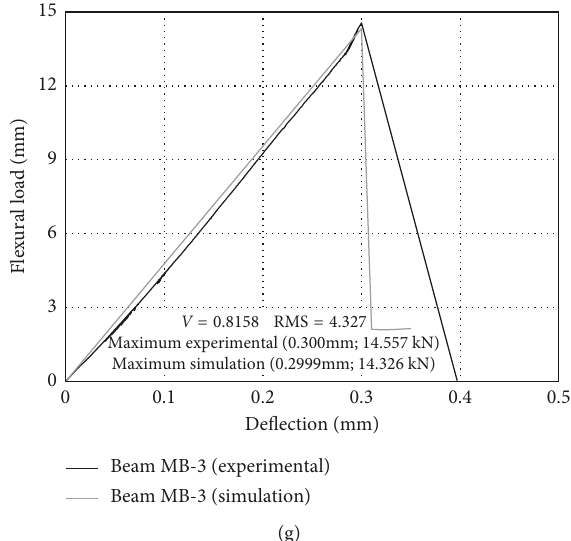
Figure 10: Experimental versus simulation load-deflection curve for series “M.” (a) Beam “S-0” (without fibres). (b) Beam “SP-1” (1% PVA fibres). (c) Beam “SB-1” (1% basalt fibres). (d) Beam “SP-2” (2% PVA fibres). (e) Beam “SB-2” (2% basalt fibres). (f) Beam “SP-3” (3% PVA fibres). (g) Beam “SB-3” (3% basalt